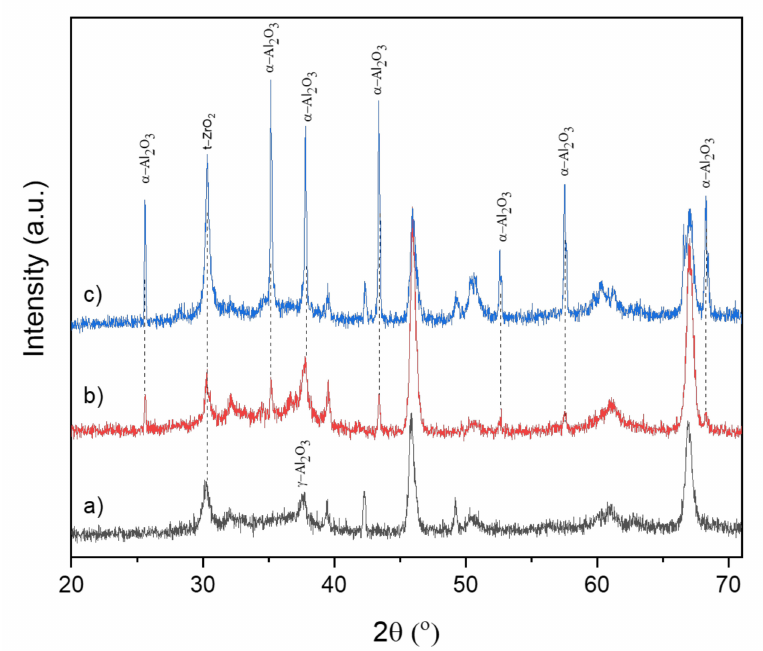
Figure 8. XRD pattern of Al 2 O 3 /glass–ceramic coating on CuZn substrate. ( a ) Only annealed at 850 ◦ C at 60 min without any laser post-annealing; ( b ) annealed at 850 ◦ C at 60 min and under CO 2 laser using 0.69 W/cm 2 power density for 1 min; ( c ) annealed at 850 ◦ C and under CO 2 laser using 1.04 W/cm 2 power density for 1